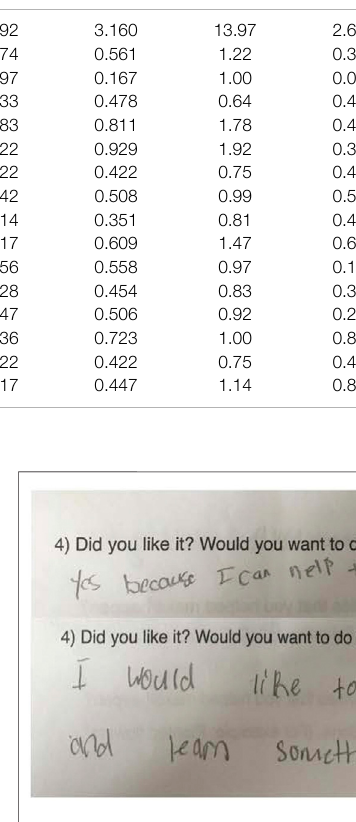
FIGURE 2 | Third-grade student comments after science eco- solutioning unit on local